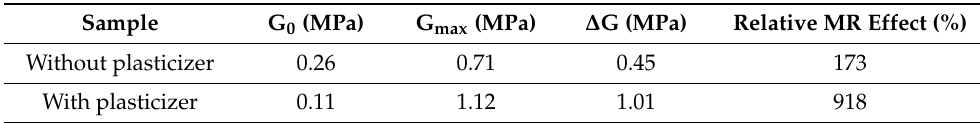
Table 4. The initial storage modulus (G 0 ), the magnetic-induce modulus ( ∆ G) and the MR effect of MRE 45 ◦ with and without plasticizer.